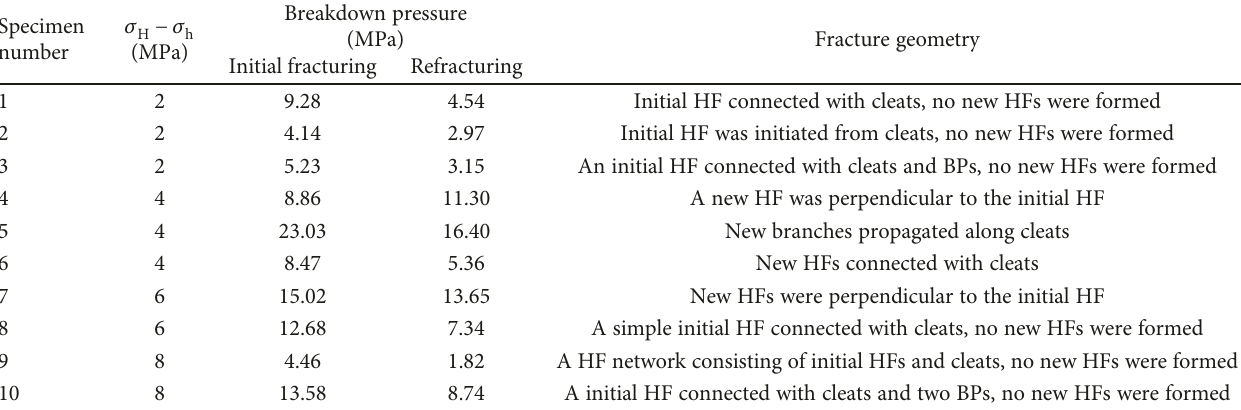
Table 3: Experimental parameters and results of refracturing in